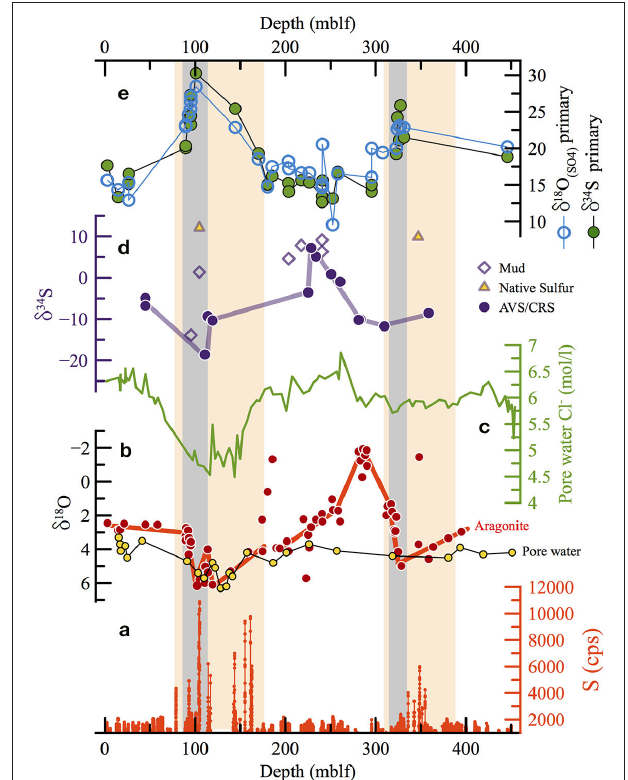
FIGURE 5 | The DSDDP core. (a) Abundance of sulfur from XRF scanning, (b) δ 18 O of aragonite laminae (red, from Torfstein et al., 2015) and pore waters (yellow, from Lazar et al., 2014) (note the reverse y axis). (c) Chloride concentrations in pore waters (from Lazar et al., 2014), (d) δ 34 S ( h ) of reduced sulfur minerals. Full circles represent the AVS and CRS fractions, and empty diamonds mark sulfate extracted from in mud intervals. Yellow triangles mark native sulfur nodules. (e) δ 34 S and δ 18 O (SO4) of primary gypsum. The similar trends of both isotopic systems, with a gradual rise toward maximum values in the two deglacial stages (marked by gray rectangles). Interglacial stages are characterized by consistently low values ca. 14–20 h . The orange rectangles mark the depth interval corresponding to two glacial cycles (MIS6 and last glacial). δ 34 S of primary gypsum and AVS/CRS fractions displays decoupling, whereby the highest δ 34 S of primary gypsum correspond to the interval of low δ 34 S of AVS/CRM minerals, while during interglacial stages, characterized by relatively low primary gypsum δ 34 S, the AVS/CRS δ 34 S is relatively high. This pattern supports the isotopic fractionation decoupling of sulfur phases in the high and stratified lake (during wet glacials) compared to a very weak decoupling during arid interglacials, when the lake is relatively low, mixed and the water column probably oxidized more frequently. High sulfur concentrations are observed during deglacials, representing the deposition of massive gypsum